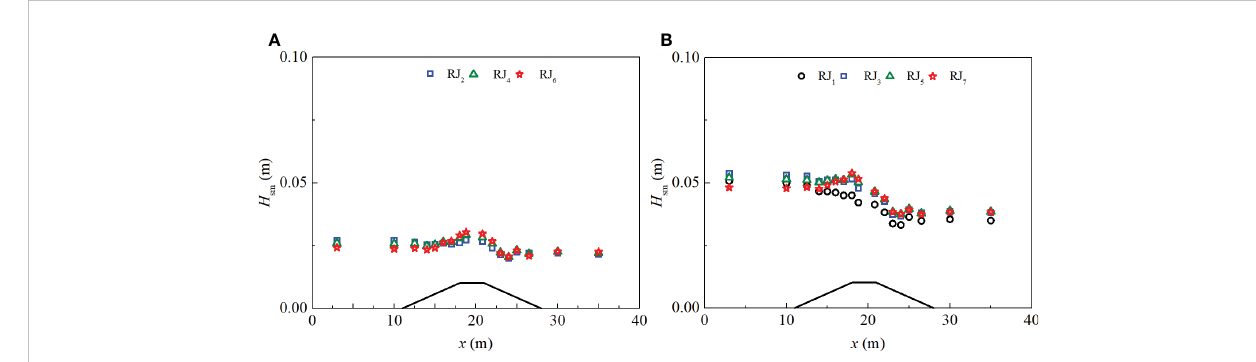
FIGURE 4 The evolutions of the mean signi fi cant wave heights for cases (A) with H s = 0.025 m and (B) with H s = 0.05